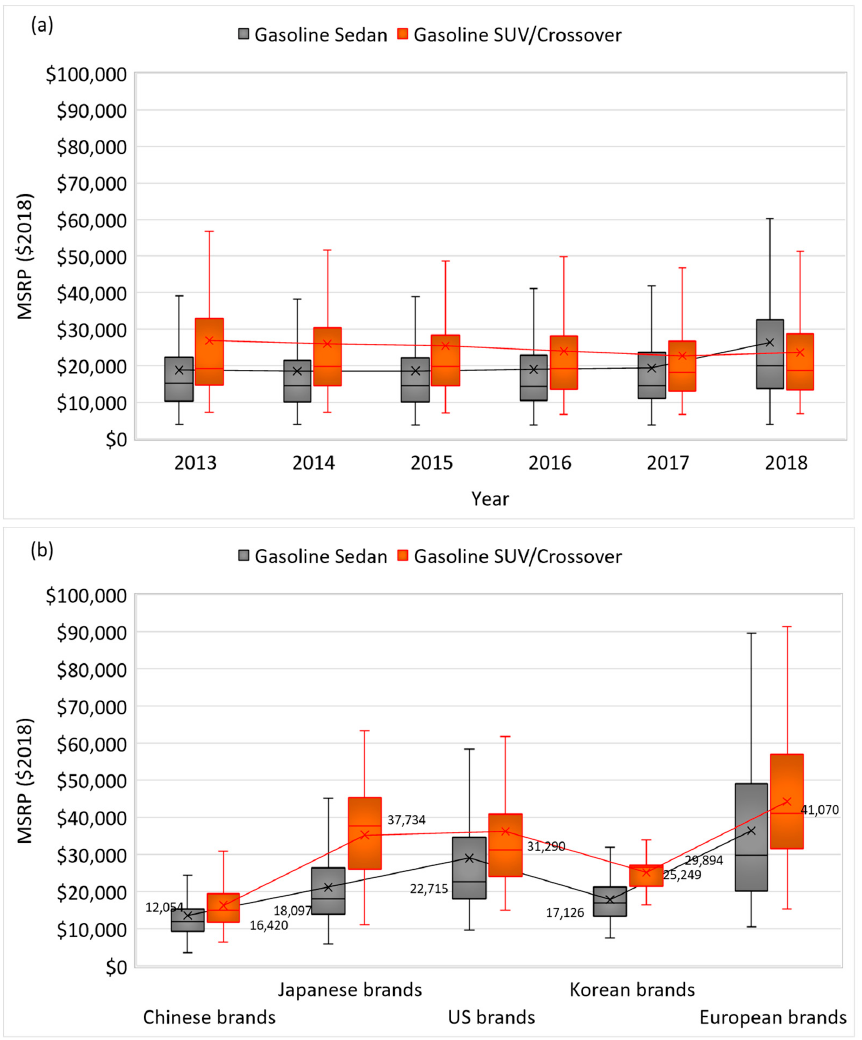
Figure 10. ( a ) Distributions of vehicle manufacturer's suggested retail price (MSRP) by year in 2013- 2018; ( b ) distributions of vehicle MSRP vehicle brand in